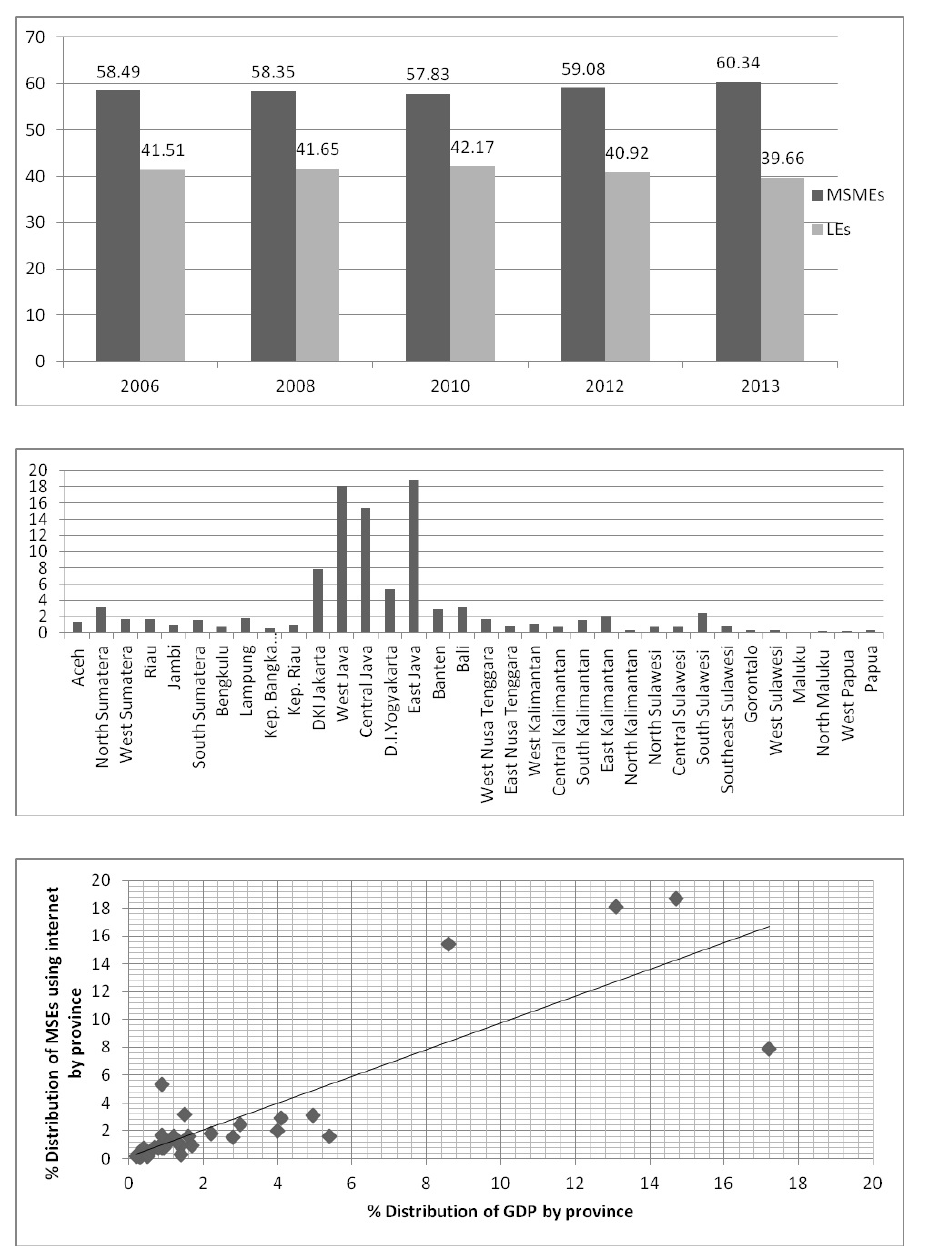
Figure 4. GDP shares of MSMEs and LEs, 2006-2013 (%).